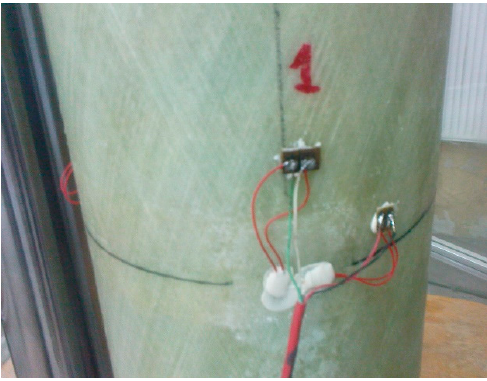
Figure 2. View of a pair of strain gauges at point 1—strain gauges in the picture covered with adhesive to protect against mechanical damage and moisture.